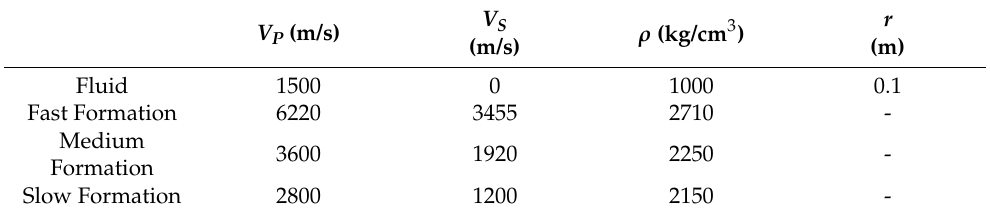
Table 1. Parameter values for model